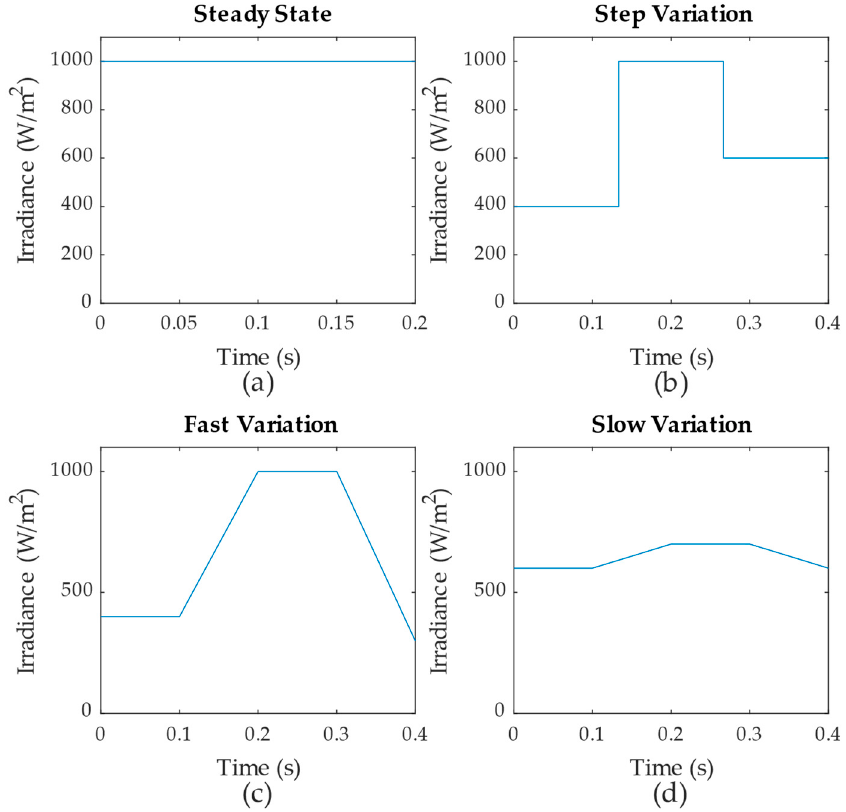
Figure 12. Irradiance level applied to PV to simulate different scenarios: ( a ) steady state; ( b ) step variation; ( c ) fast variation; and ( d ) slow variation.